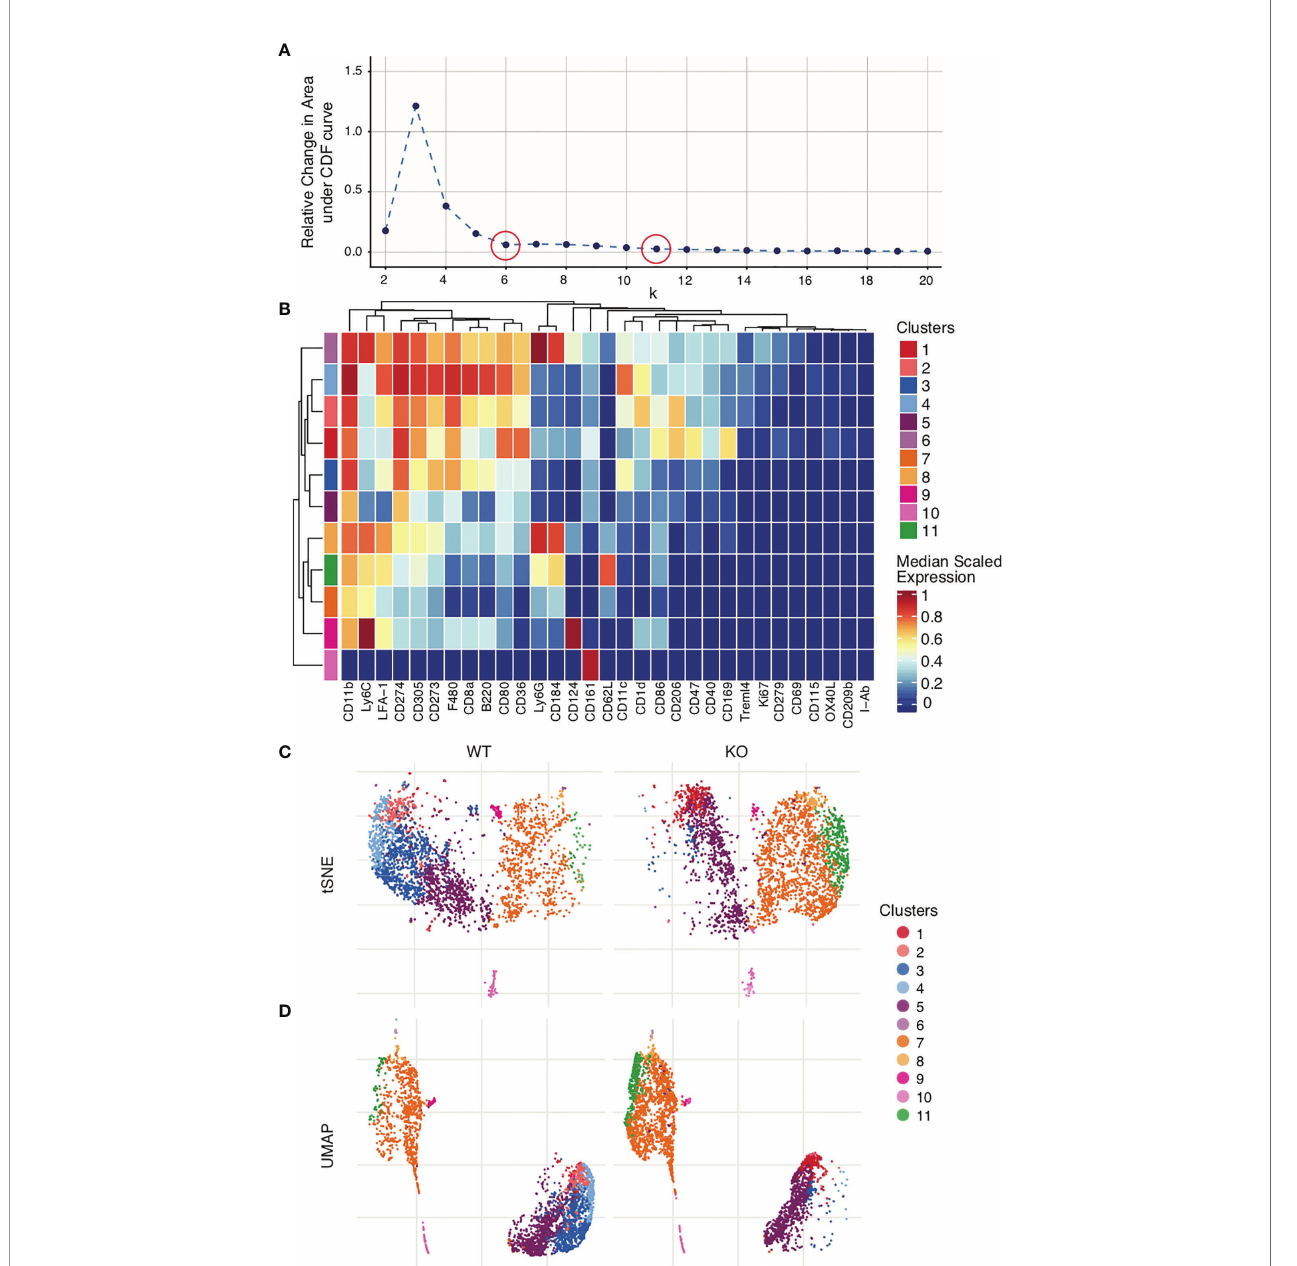
FIGURE 7 | Clustering and visualization. Mouse bone marrow-derived dendritic cells were generated. Clustering was performed on live dendritic cell singlets after Quality control and marker selection. Figures were generated in R via the CATALYST package using their standard settings. (A) Deltaplot showing relative change under the Cumulative Distribution Function (CDF) when clustering is performed using different cluster numbers. The optimal cluster number is indicated at the threshold below which a change in cluster number no longer correlates to a change under the CDF (plateau point in the graph). red circles , selected cluster values. (B) Clusters have been created across all FCS fi les. Expression levels for each marker are normalized across all clusters. The heatmap shows the normalized expression levels of each marker in each cluster in the total data set. The upper legend on the right of the heatmap indicates the clusters, coded by color to the corresponding row indicated on the far left of the heat map. The number of clusters used in the analysis was selected by deltaplot (A) . Markers were selected based on the NRS plot ( Figure 6C ). (C) tSNE comparison of WT vs KO samples, demonstrating clusters 3 and 4 severely diminished and cluster 11 greatly increased in KO as compared to WT. (D) UMAP comparison of WT vs